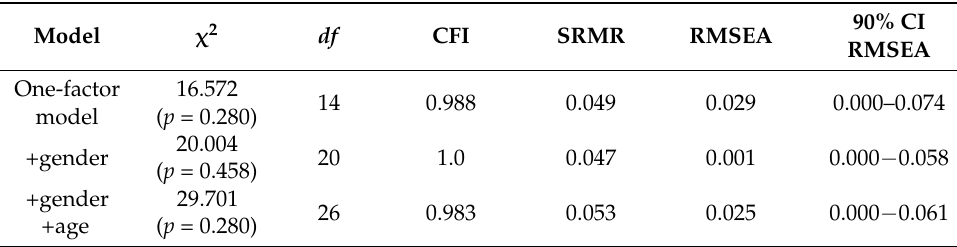
Table 3. Confirmatory factor analysis of the HIFAMS by WLSMV estimator with fit indices for 3 models.